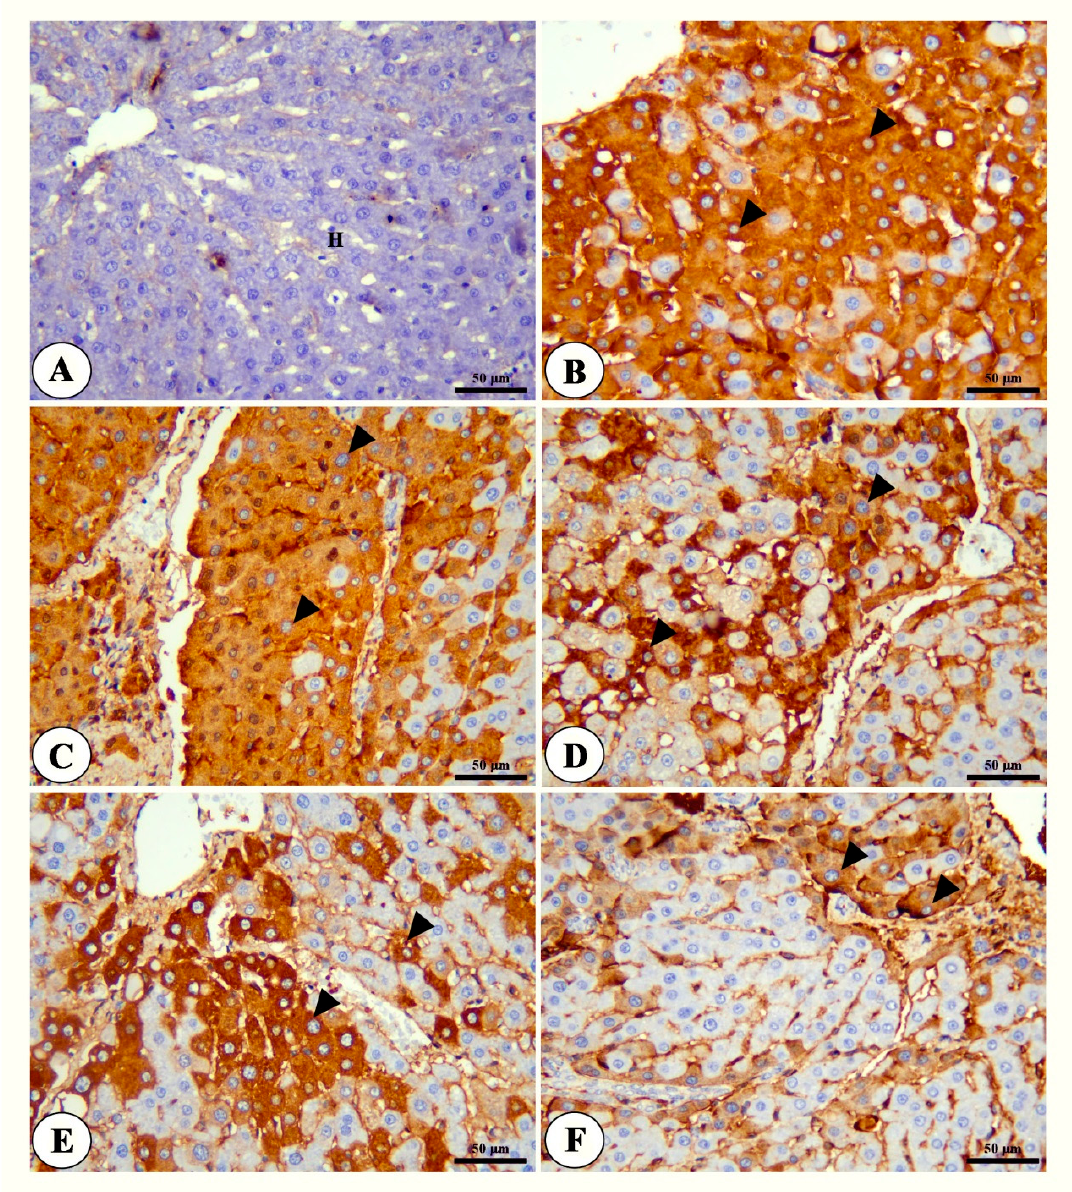
Figure 5. Photomicrograph of liver tissue of control group ( A ), HCC group ( B , C ), NSP-treated group